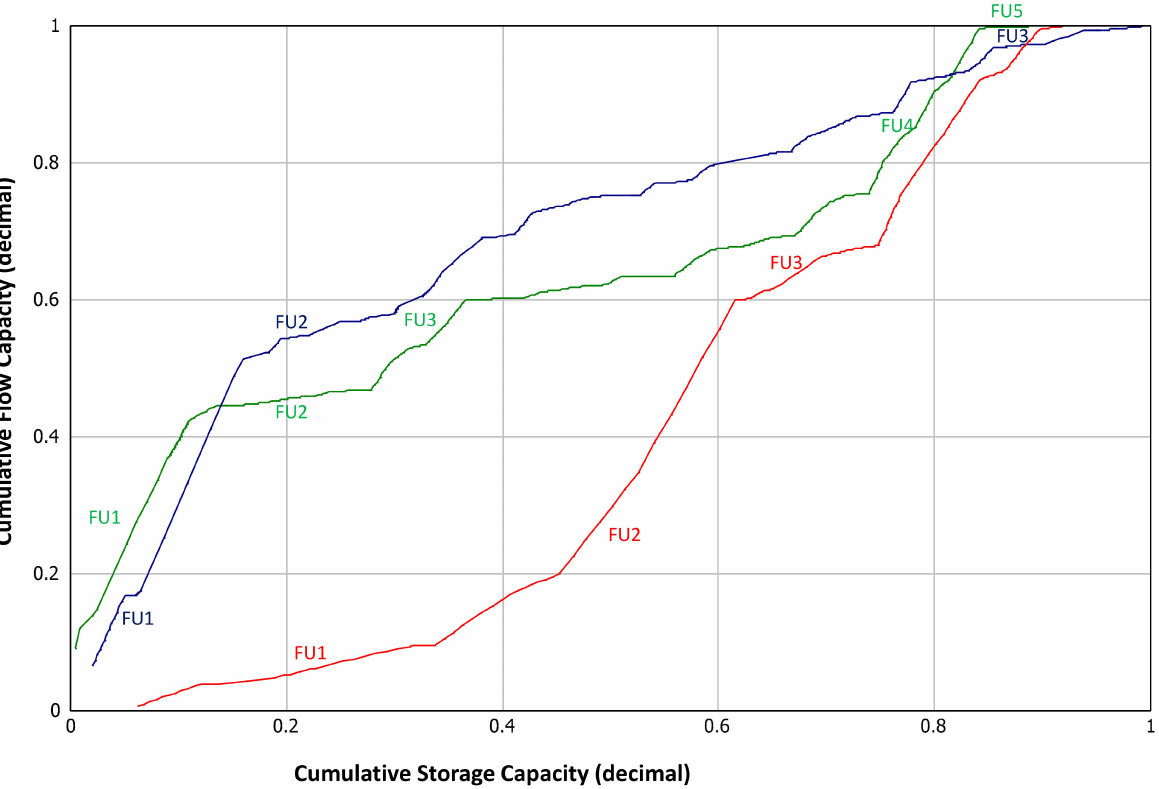
Figure 5. Plot of cumulative flow and storage capacities for wells showing five different flow units,